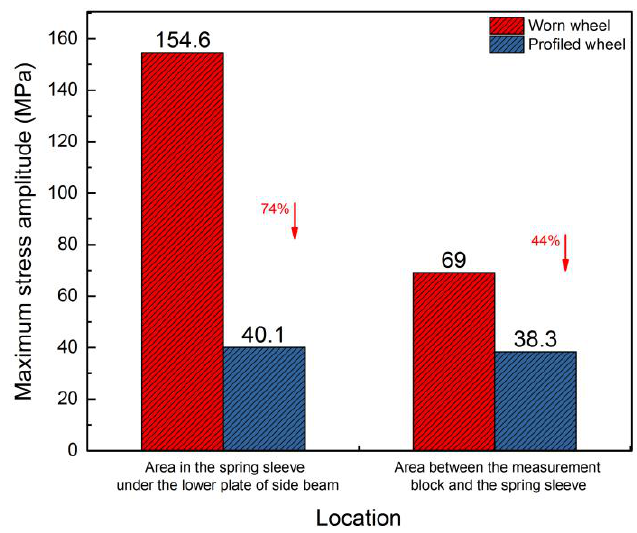
Figure 15. The comparison of the maximum stress amplitude of the profiled and worn wheels around the cracked area.